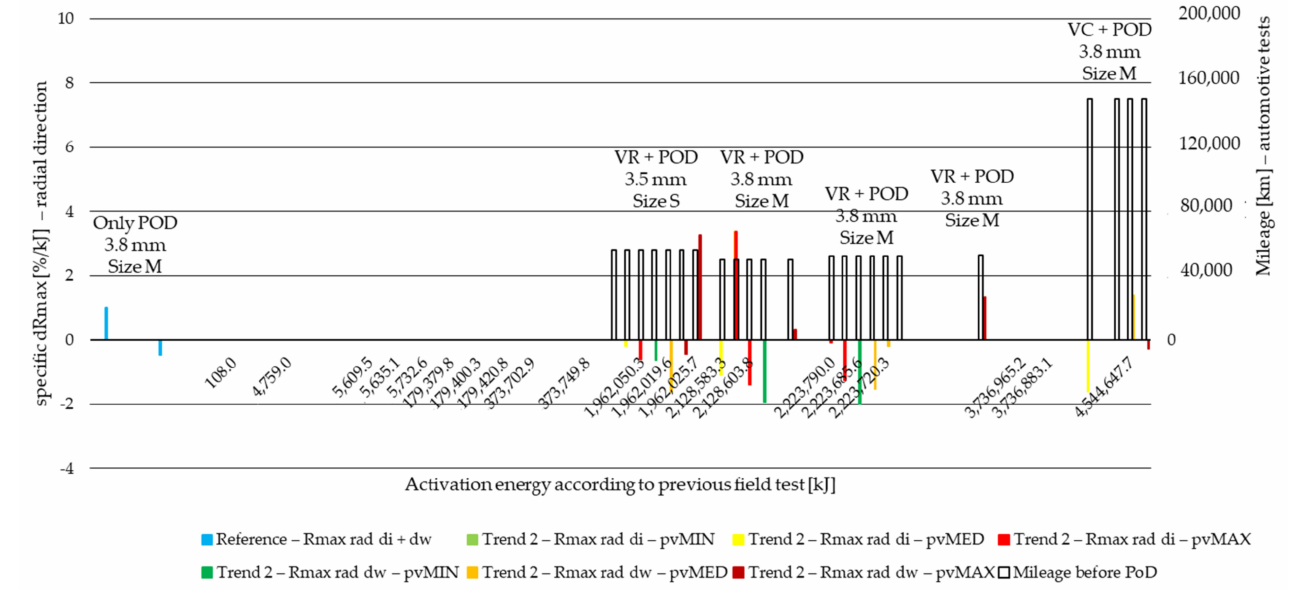
Figure A4. Radial direction PoD specific Rmax difference values of cut material samples from inner and working diameter after minimum, medium and maximum pv level pin-on-disc tests with previous field-test (Table 2) mileage along Joule scale—Trend 2: moderate load cases.